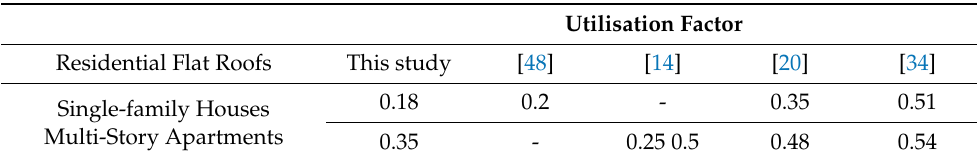
Table 3. Utilization factor compared to the literature